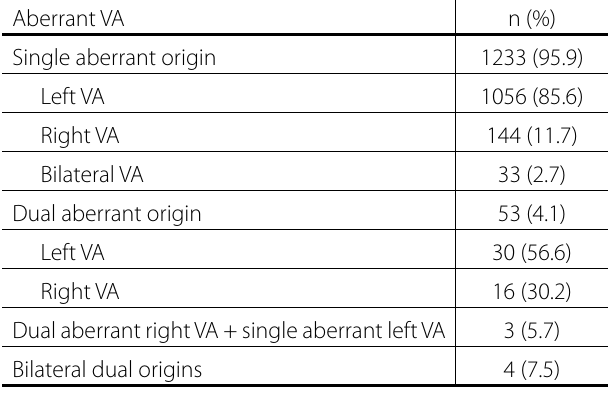
Table 2 . The aberrant vertebral artery in 1286